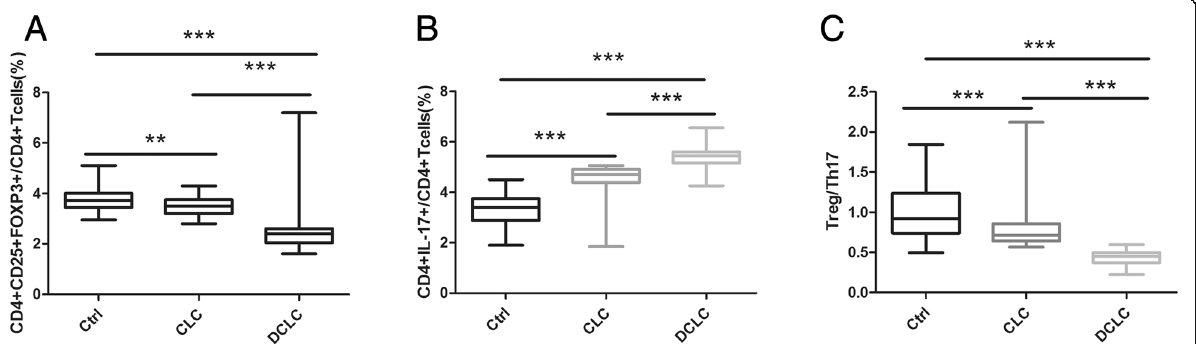
Fig. 2 Comparison of the incidence of Treg and Th17 cells and the Treg/Th17 ratio among the three groups. Ctrl refers to the control group, CLC refers to the compensated liver cirrhosis group, DCLC refers to the decompensated liver cirrhosis group. * p <0.05, ** p <0.01, *** p <0.001. a Comparison of the percentage of CD4 + CD25 + FOXP3 + Treg cells in CD4 + T cells among the three groups b Comparison of the percentage of CD4 + IL-17 + Th17 cells in CD4 + T cells among the three groups. c Comparison of the Treg/Th17 ratio among the three groups